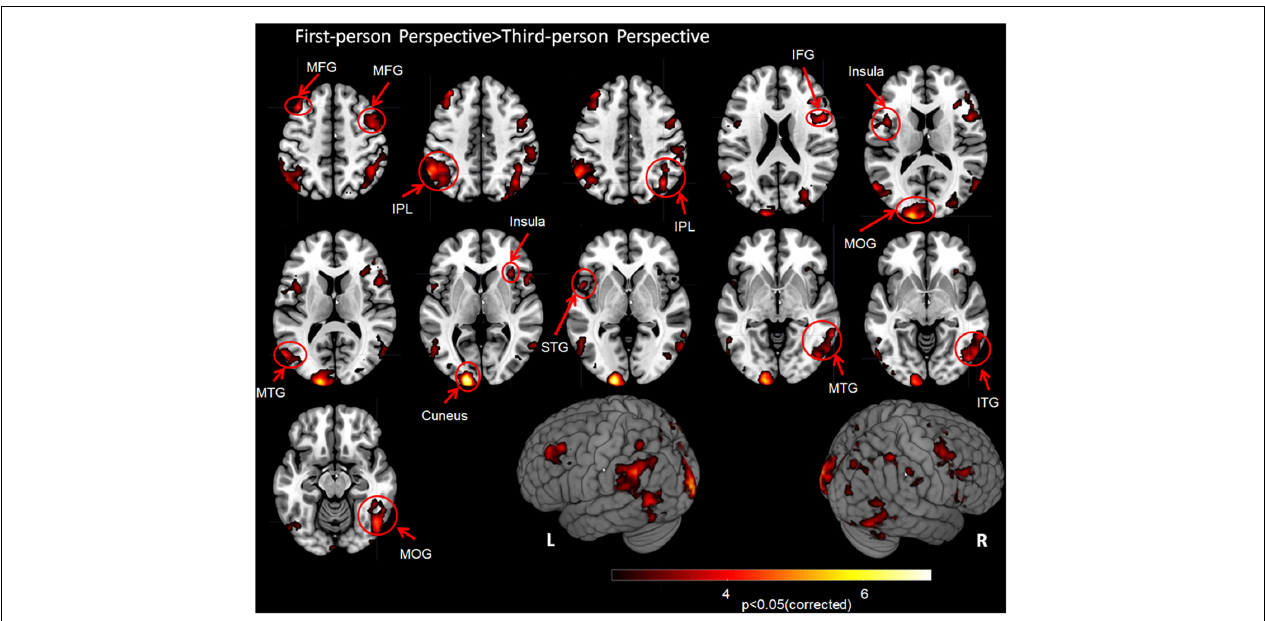
FIGURE 4 | Group analysis results for action observation and understanding from the first-person perspective vs. the third-person perspective with a Z-statistic threshold of 2.3 and corrected cluster P < 0.05. MFG, middle frontal gyrus; IPL, inferior parietal lobule; IFG, inferior frontal gyrus; MOG, middle occipital gyrus; MTG, middle temporal gyrus; STG, superior temporal gyrus; ITG, inferior temporal gyrus; L, left hemisphere; R, right hemisphere. TABLE 1 | Activated areas related to the first-person perspective vs. third-person perspective with locations for simple T contrasts. Cluster Index